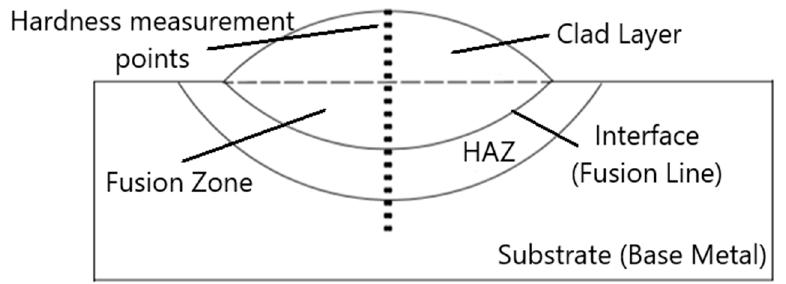
Figure 10. Scheme of hardness measurements and characteristic features of single bead geometry, as shown in Figure 11.